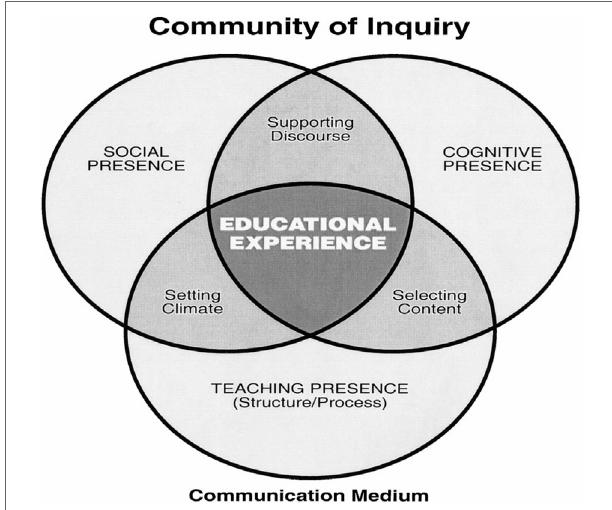
FiGuRe 2 | Community of Inquiry model (Garrison et al., 2000). Reproduced with permission from the